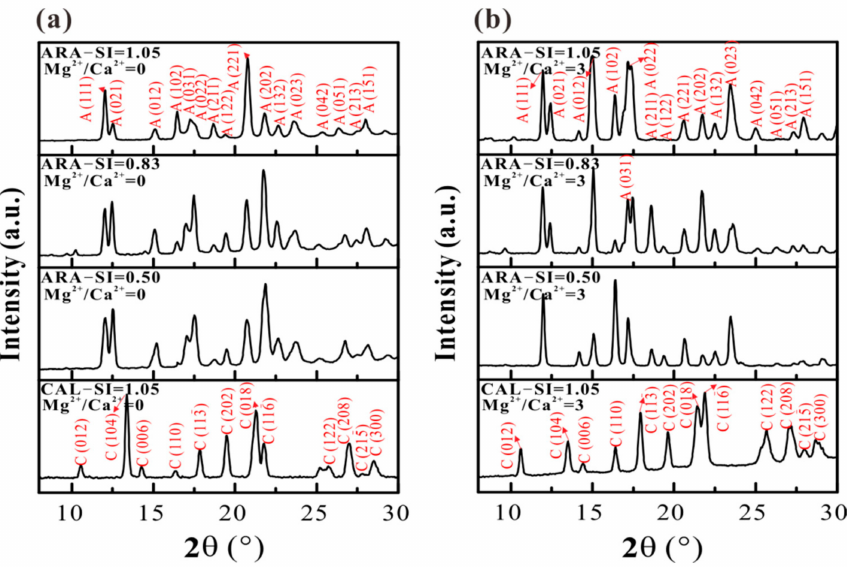
Figure 10. XRD patterns of the calcite (104) and aragonite (110) substrates after growing in solutions at SI calcite = 0.50 – 1.05 with ( a ) Mg 2 + / Ca 2 + = 0, and ( b ) Mg 2 + / Ca 2 + =